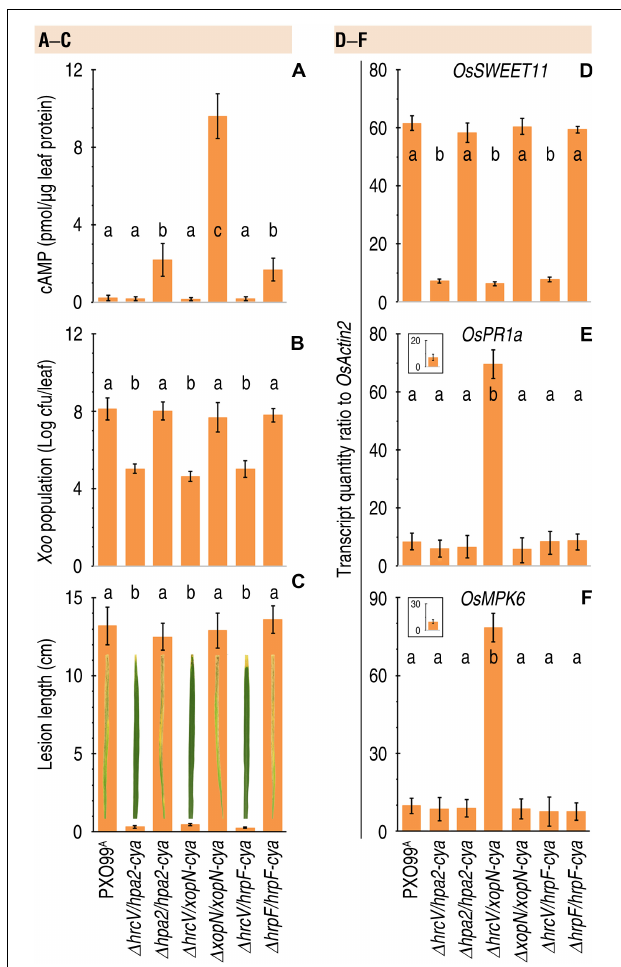
FIGURE 7 | The coincident effects of Hpa2, HrpF, and XopN translocation on bacterial virulence and rice defense responses. (A–F) Leaves of 14-day-old Nipponbare rice seedlings were inoculated by infiltration with bacterial suspensions of PXO99 A and the complementing strains with and without the hrcV gene, respectively. Inoculated leaves were excised and used in the different assays. Quantitative data are given as the means ± SDs. Different letters on bar graphs indicate significant differences of data obtained from the experiments performed on the different bacterial strains (ANOVA and Duncan’s test, P < 0.001, n = 3 independent experiment each involving 30 leaves of 15 plants). (A) Translocation levels of the Cya-fused proteins shown as cytoplasmic cAMP concentrations in leaves 12 hpi. (B) Bacterial population in leaves 3 dpi. (C) Leaf blight symptoms and severity qualification at 7 dpi. (D–F) Rice gene expression in leaves 48 hpi. Gene expression was analyzed by RT-qPCR using the constitutively expressed OsActin2 gene as a